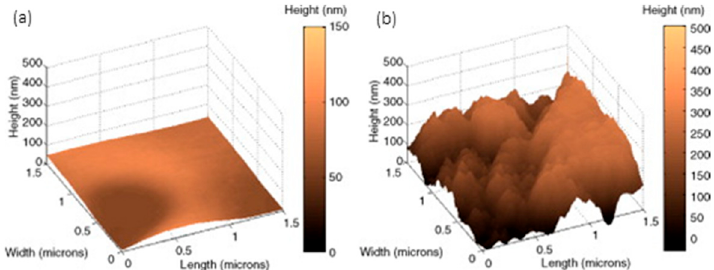
Figure 31. ( a ) AFM image from a [PAH+HTTPS/PAA] coating (left hand side image) and one with a hydrophilic coating deposited below (right hand side image); ( b ) the second one shows a higher roughness that enhances the sensitivity of the sensor. Reprinted from [155] with permission from Elsevier.